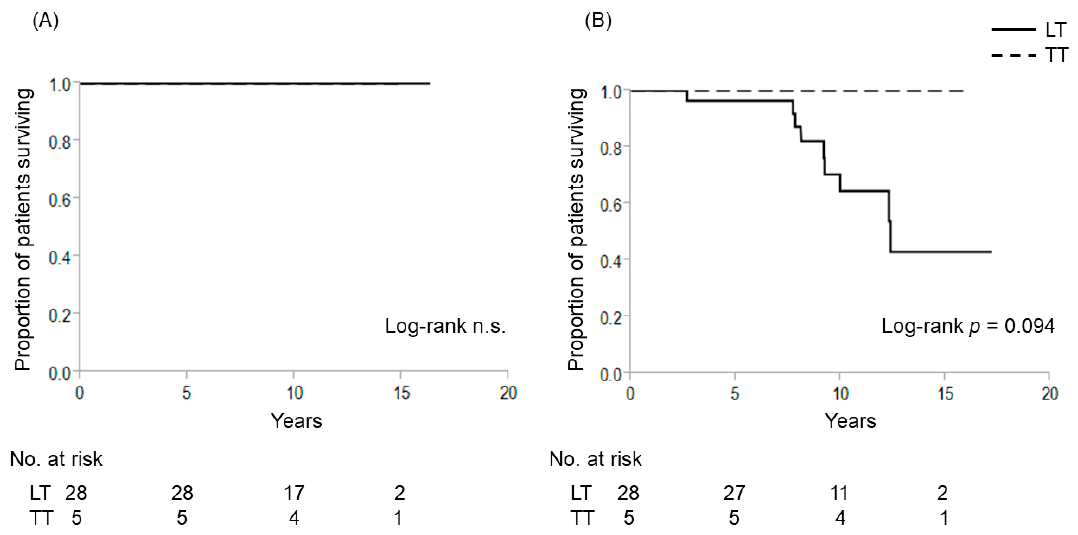
Figure 5. Cause-specific and disease-free survival curves for patients without TERT promoter mutations who underwent lobectomy and total thyroidectomy after propensity score-matching for patients with intrathyroidal PTC with a maximal diameter of 1–4 cm. ( A ) Cause-specific survival; ( B ) disease-free survival. LT, lobectomy; TT, total thyroidectomy.